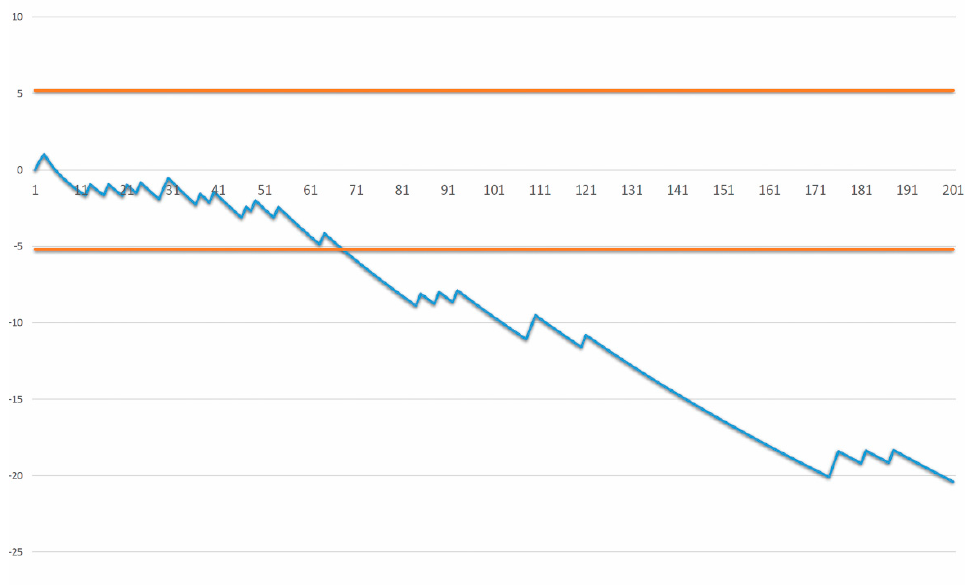
Figure 4. Moving average of estimated risk of complications according to comprehensive complication index (cut off 40). The x-axis represents the operation number. The LC according to the length of stay (LOS) is shown in Figure 5. After 58 CRS + HIPEC procedures performed, the LC tends to decrease. The MA of LOS in subsequent cases is below 10.